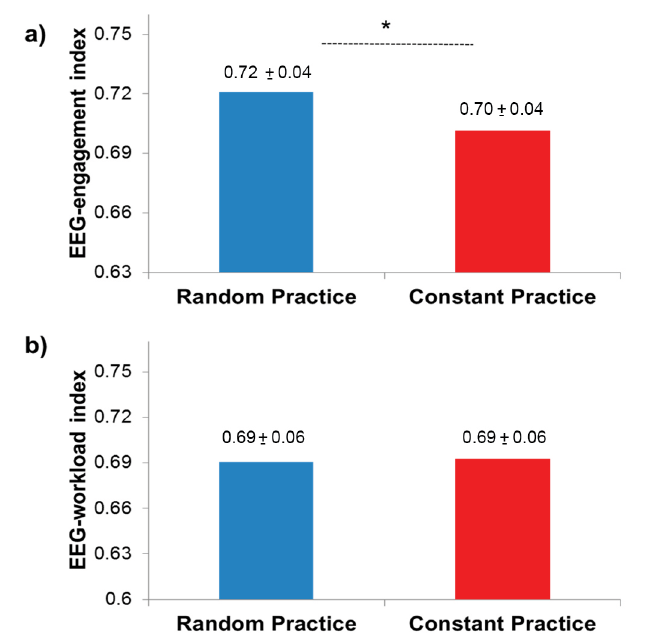
Figure 3. Means of the ( a) EEG-engagement index and ( b ) EEG-workload index in the random and constant practice conditions ( * represents significant difference).